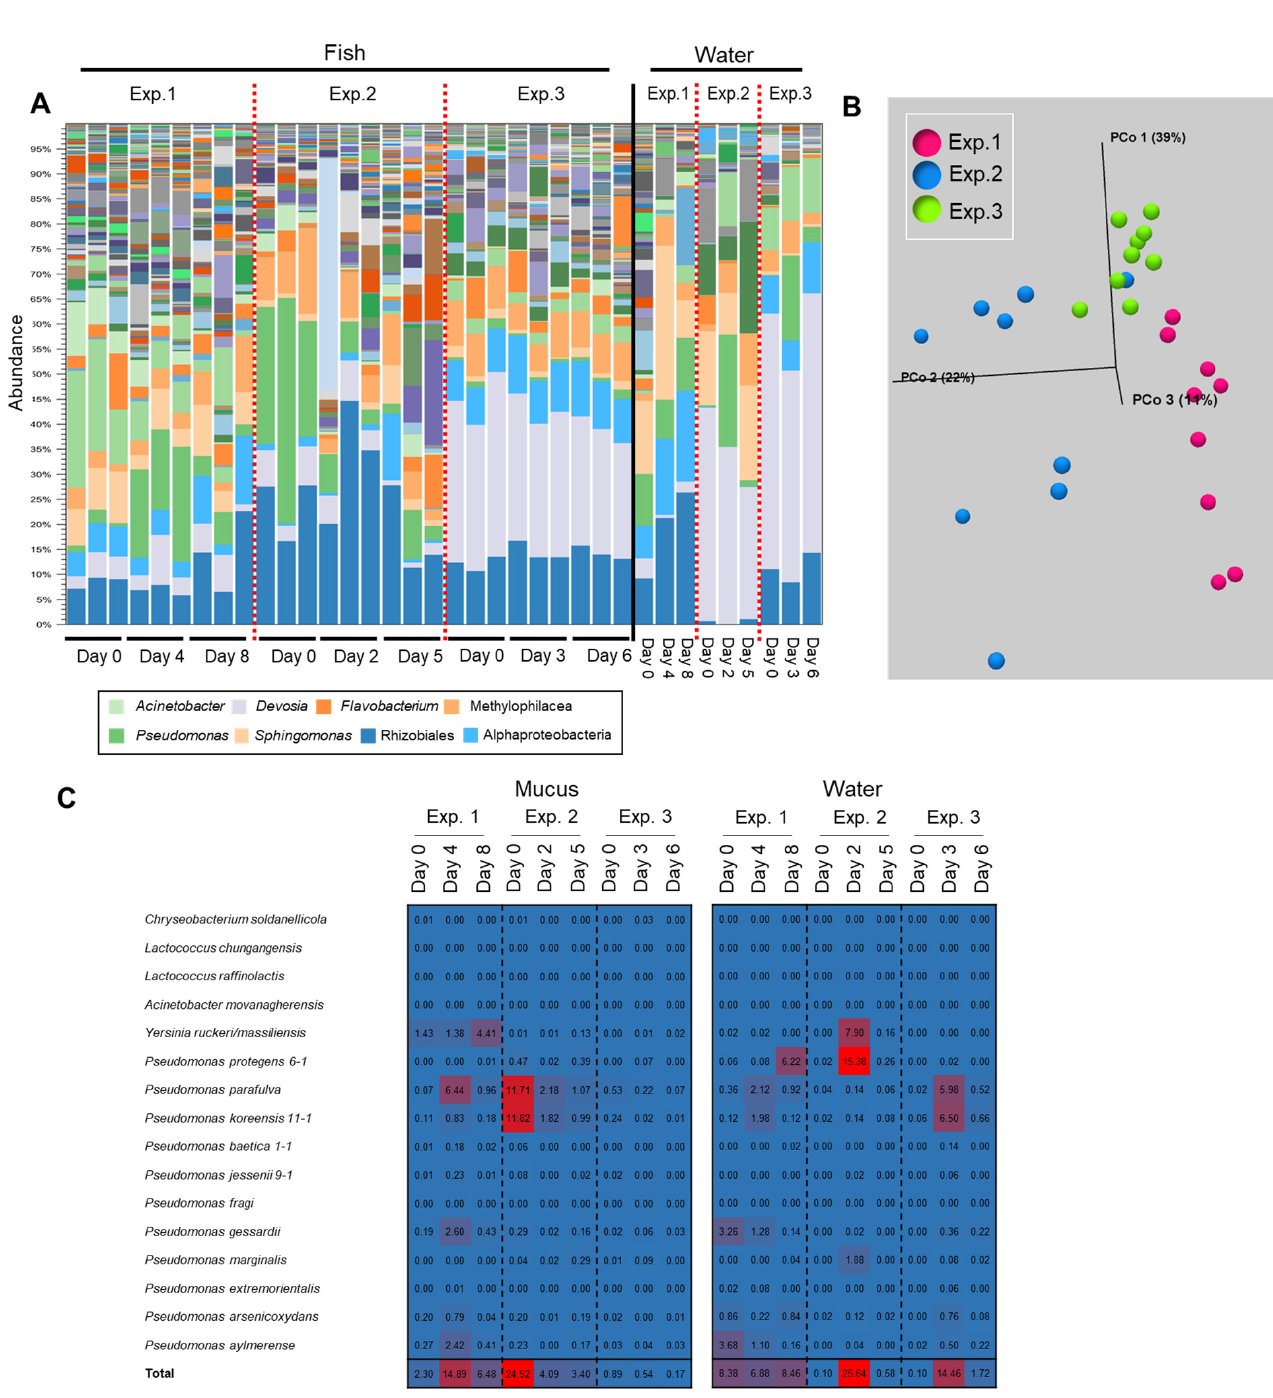
Figure 6. Results depicting a transition of the epidermal mucus bacterial flora of rainbow trout reared in a laboratory aquarium with a recirculating system. ( A ) The stacked bar chart shows the abundance of major bacterial flora in the epidermal mucus and rearing water, in an experiment performed three times (Exp. 1–3). ( B ) Beta-diversity measured by weighted UniFrac distance using fish skin mucus samples from Exp. 1, 2, and 3. ( C ) Reads mapped on the antimicrobial bacterial 16S rDNA sequences; the proportions of mapped reads from each day are depicted in a heatmap.